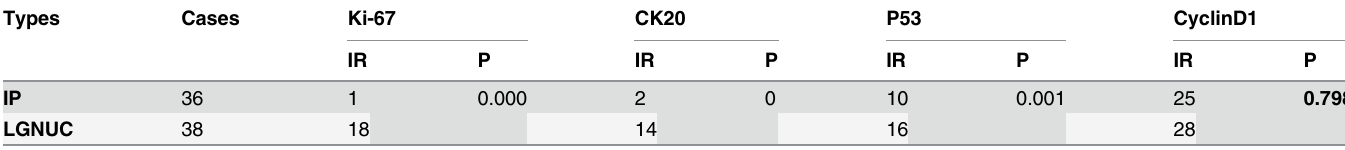
Table 2. Comparison of immunohistochemical features of IUP and LGNUC with an inverted growth